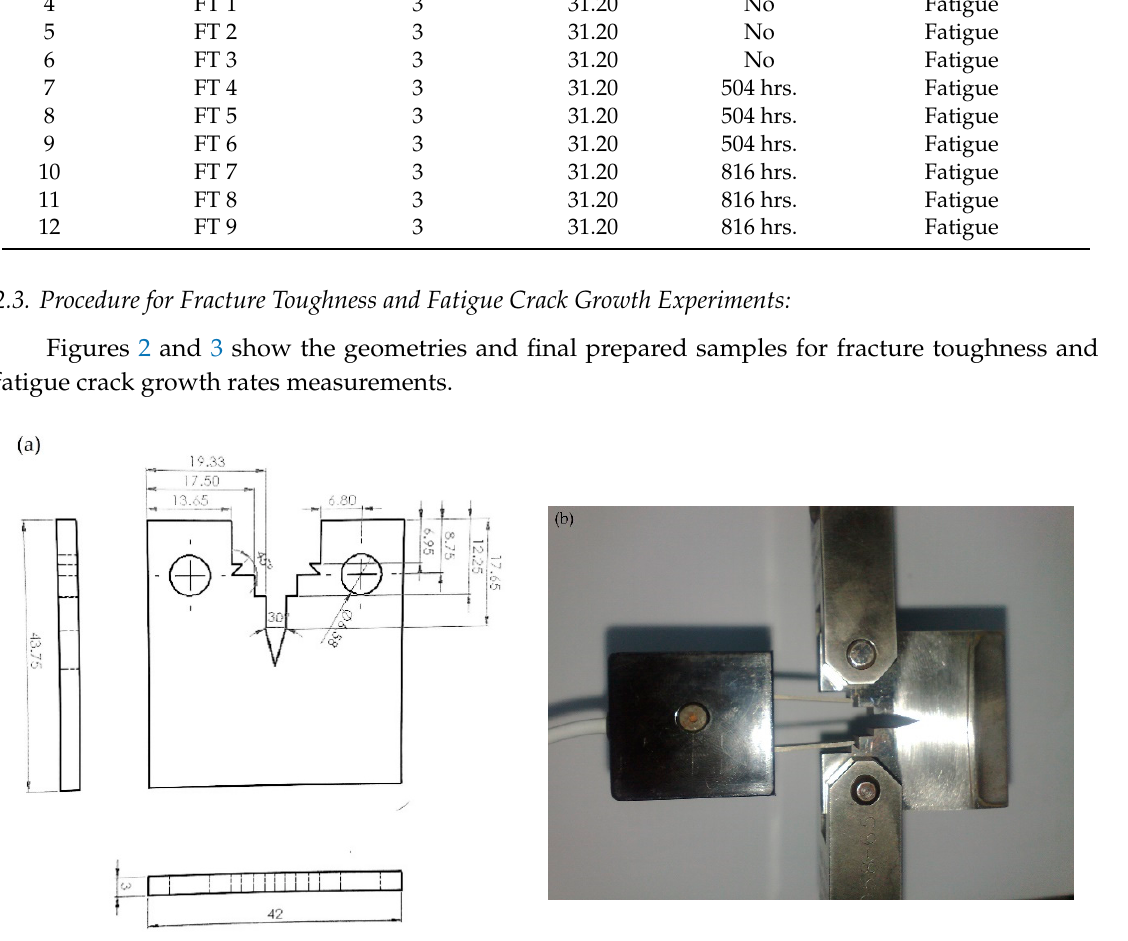
Figure 2. CT specimens for Fracture Toughness Test ( a ) Geometry of the specimen ( b ) Photograph of in-test